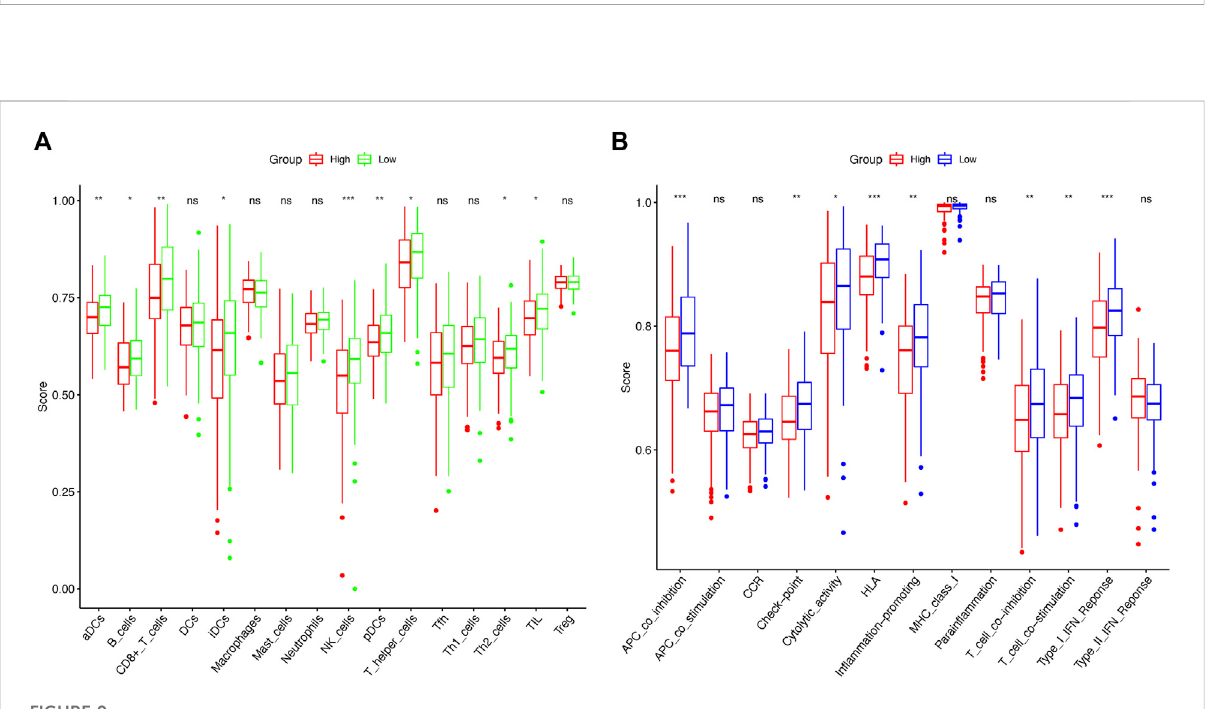
FIGURE 9 Comparison of ssGSEA scores between the low-risk and high-risk groups in TCGA cohort. Enrichment scores of 16 immune cells (A) and 13 immune-related pathways (B) between the two risk groups in cervical cancer samples. p -values were represented as follows: ns, not signi fi